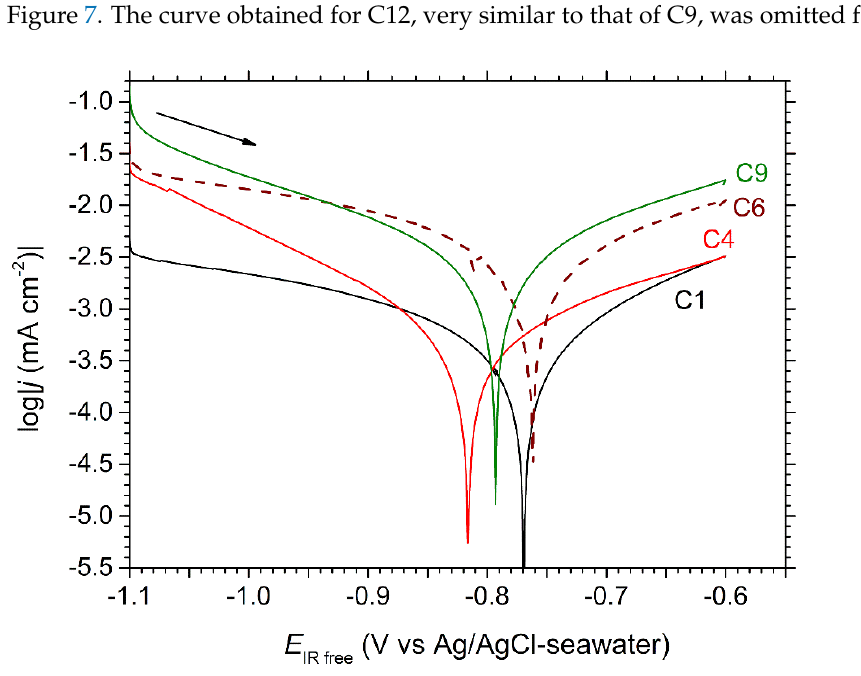
Figure 7. Polarization curves (log| j | vs. E ) acquired at the end of the experiment for coupons C1 (black line), C4 (red line), C6 (brown dotted line) and C9 (green line). C1 (black line), C4 (red line), C6 (brown dotted line) and C9 (green